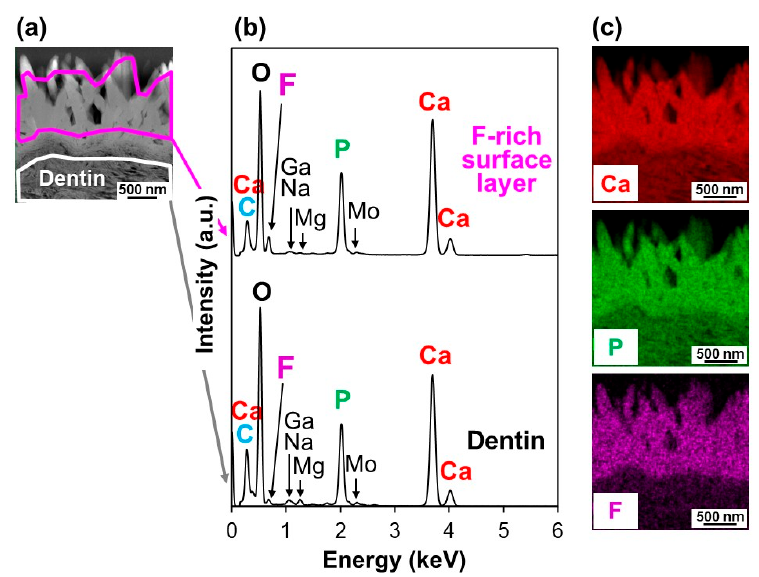
Figure 6. ( a ) Cross-sectional HAADF-STEM image of the surface of the LAB-processed substrate ICG3W, ( b ) STEM-EDX spectra obtained from the boxed regions in ( a ), and ( c ) STEM-EDX elemental (Ca, P, F) maps of ( a ).